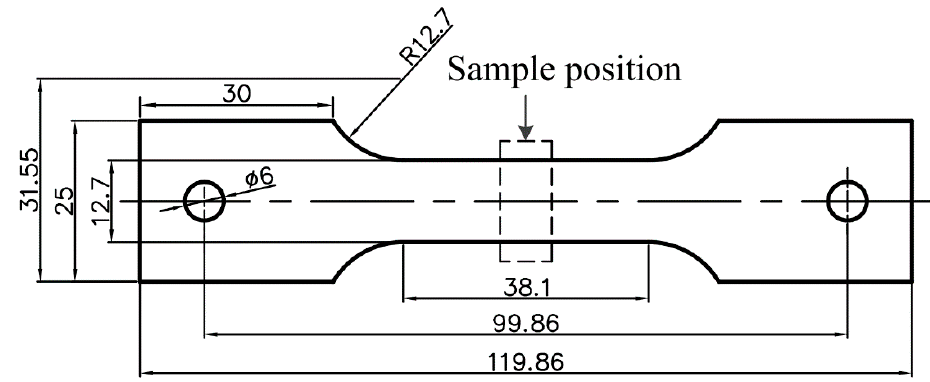
Figure 4. Heating samples (units: mm).